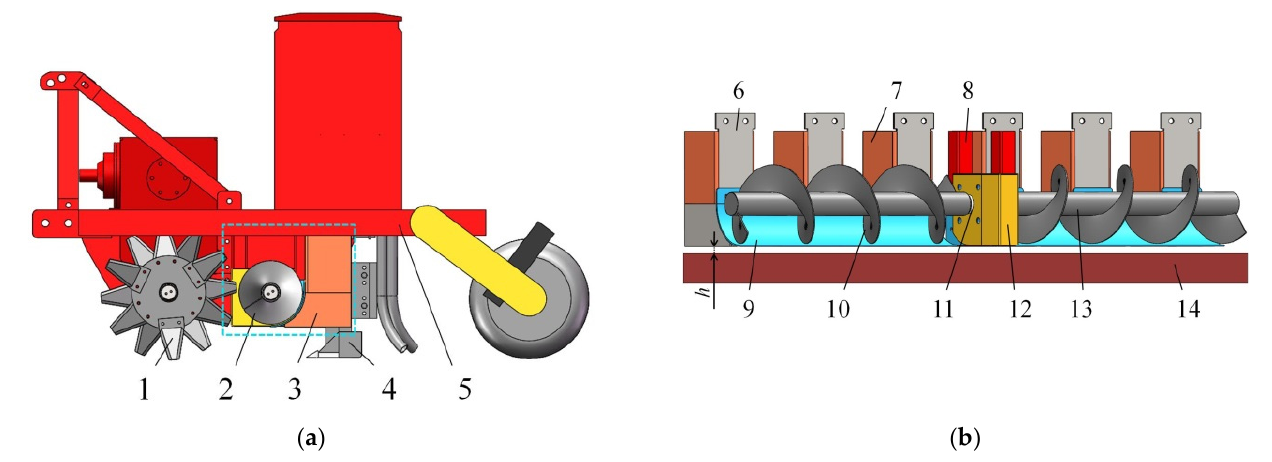
Figure 1. SDARD with its specific position. ( a ) Installation position of SDARD of wheat no-till planter; ( b ) the structure of SDARD. Note: 1, NAKG; 2, SDM; 3, RSM; 4, furrowing opener; 5, frame; 6, seed strip baffle; 7, side baffle; 8, support-connecting; 9, holding hopper; 10, spiral blade; 11, rolling bearing; 12, inclined anti-winding plate; 13, spiral shaft; 14, soil. h is the height of the hopper above the ground, mm. h also indicates a gap between the hopper (9) and the soil (14). Moreover, there is no contact. h > 0.